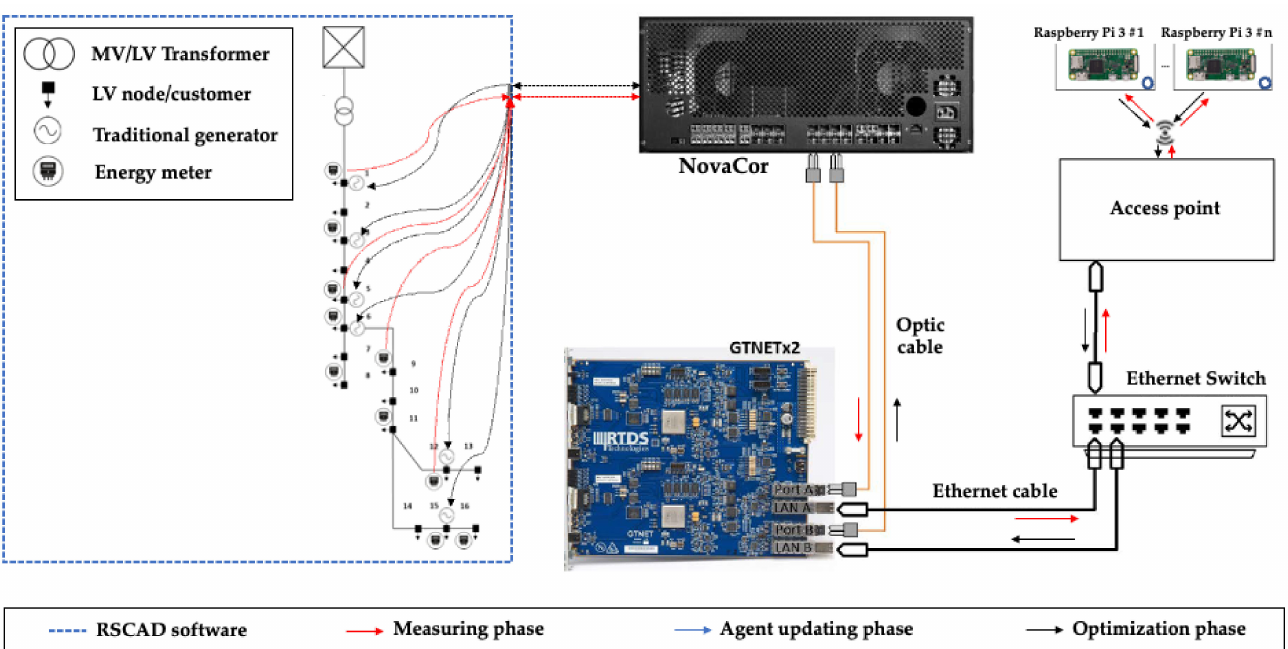
Figure 6. Laboratory